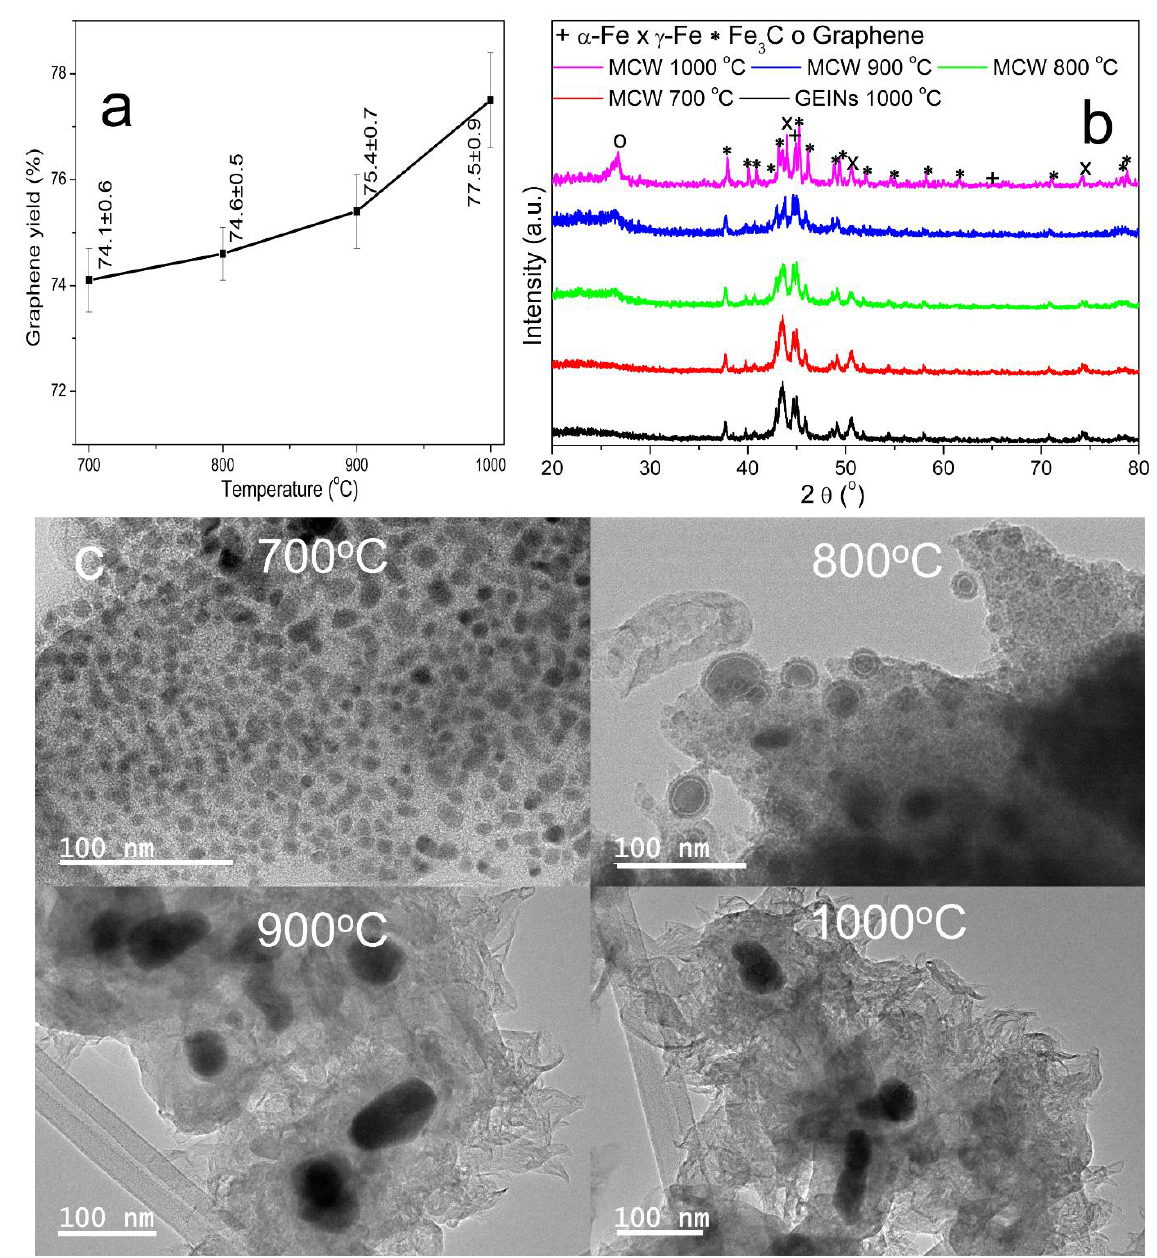
Figure 6. Yield of graphene materials ( a ). X-ray diffraction (XRD) patterns ( b ) and HRTEM images ( c ) of the cracked GEIN samples by methane molecules for 1 h at different reaction temperature of 700, 800, 900, and 1000 °C.